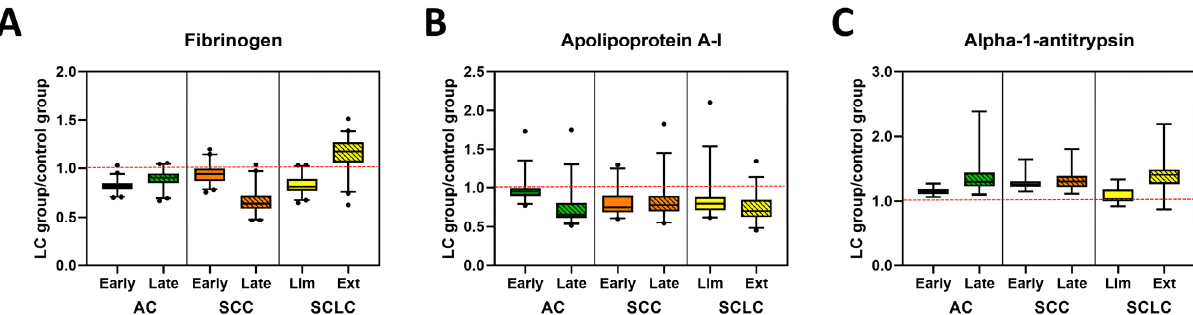
Figure 4. Glycosylation profiles of selected plasma proteins in control and lung cancer patient specimens. Examples of glycosylation levels of selected proteins involved in coagulation ( A ), transportation ( B ) or belonging to the serpins family ( C ) in patients with different stages of AC, SCC, and SCLC. Data are presented normalized to control values, (LC group)/(Control group). The dashed red line indicates the median value of control samples.